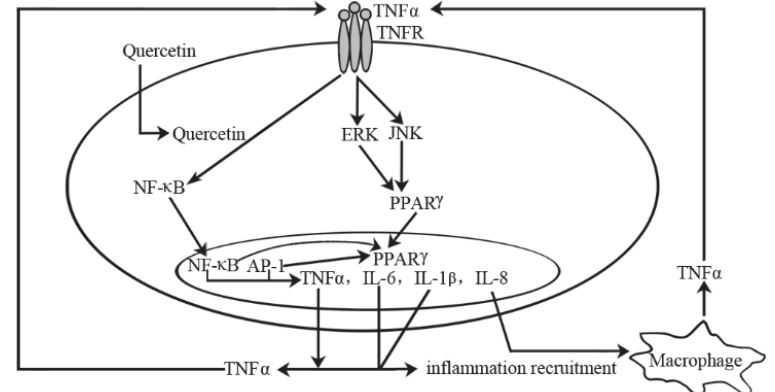
Figure 2. Working model on how quercetin block tumor necrosis factor- α (TNF α )-mediated inflammation. Quercetin prevents TNF- α from directly activating extracellular signal-related kinase (ERK), c-Jun NH 2 -terminal kinase (JNK), c-Jun, and nuclear factor- κ B (NF- κ B), which are potent inducers of inflammatory gene expression and protein secretion. In addition, quercetin may indirectly prevent inflammation by increasing peroxisome proliferator-activated receptor c (PPAR γ ) activity, thereby antagonizing NF- κ B or activator protein-1(AP-1) transcriptional activation of inflammatory genes. Together, these block TNF- α -mediated induction of inflammatory cascades.